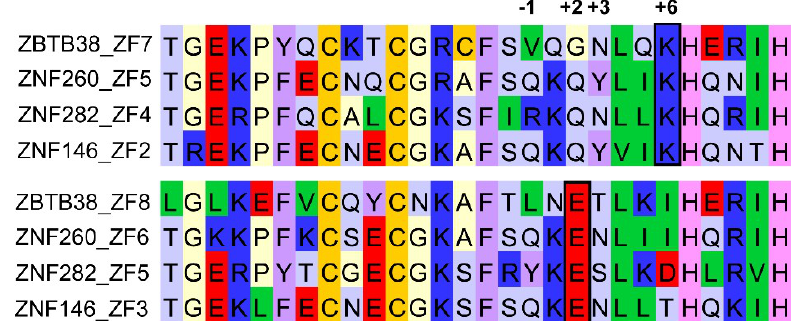
Figure 4. Sequence alignment for additional ZF proteins that share the conserved lysine/glutamate residue pair (boxed) that was shown for the C-terminal ZFs of ZBTB38 to participate in selective mCpG recognition.